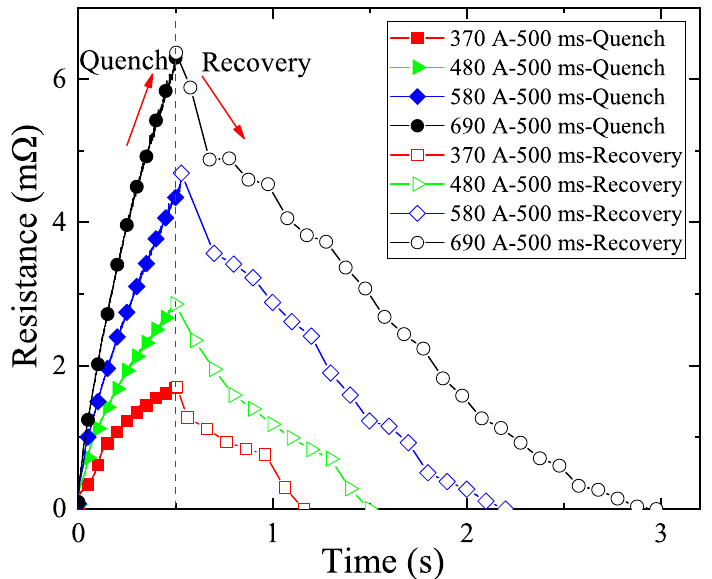
Figure 3. Resistance of the sample during the quench and recovery process at impact currents of 370 A, 480 A, 580 A and 690 A when the pulse duration was 500 ms. The peak resistance occurred at 500 ms when the impact current ended. The peak resistance of the sample increased with the increasing amplitude of the impact